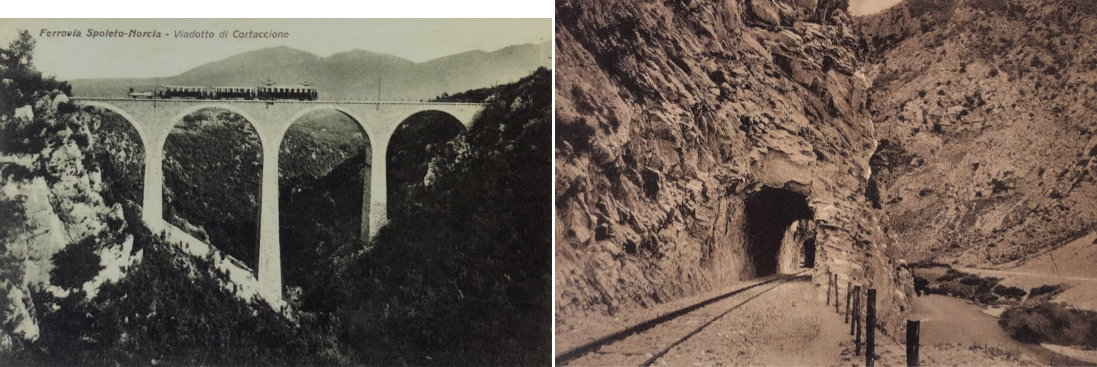
Figure 2. Examples of work along the track: viaduct and tunnel (courtesy by Umbriamobilita